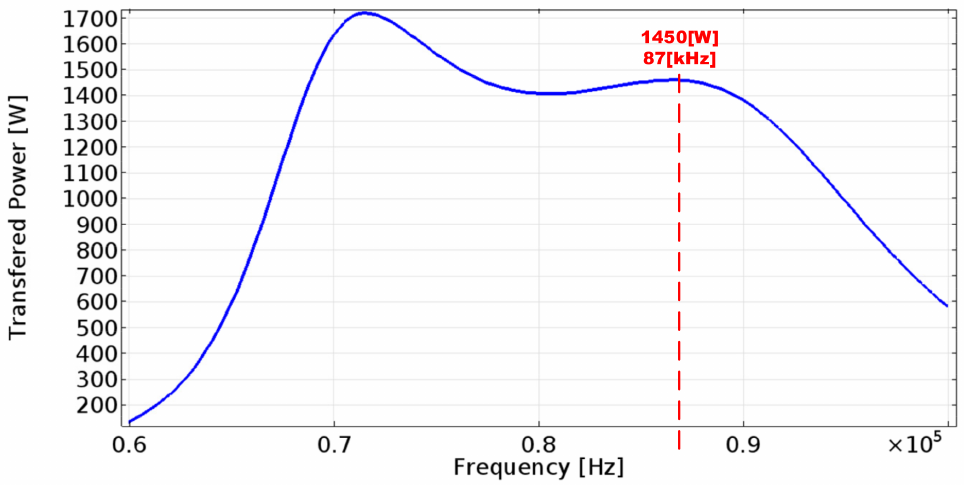
Figure 8. Frequency characteristic of the WPT system for the EMF distribution from Figure